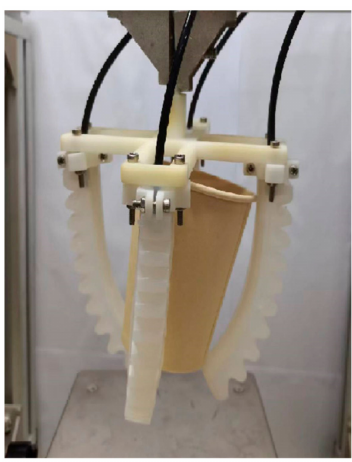
Figure 19. Test on the maximum grasped weight of the soft gripper.